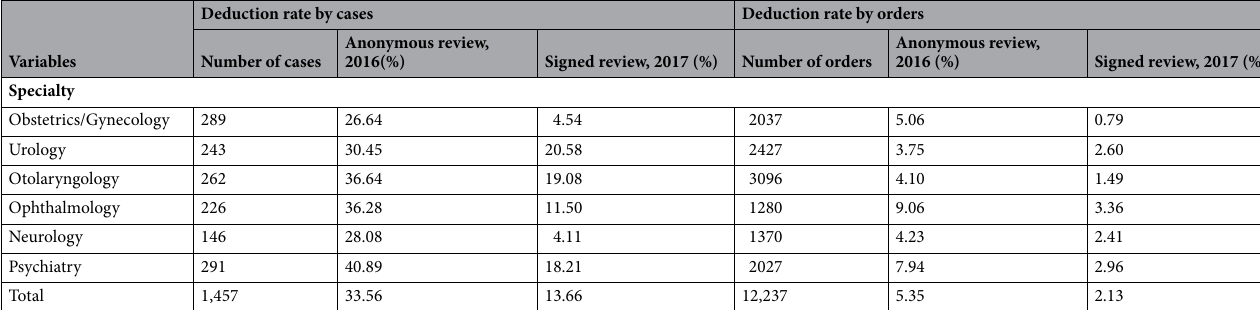
Table 2. Deduction rate of the reimbursement claims before and after the signed review policy under the Taiwanese National Health Insurance scheme. All of the differences between 2016 and 2017 are statistically significant with P < 0.01.